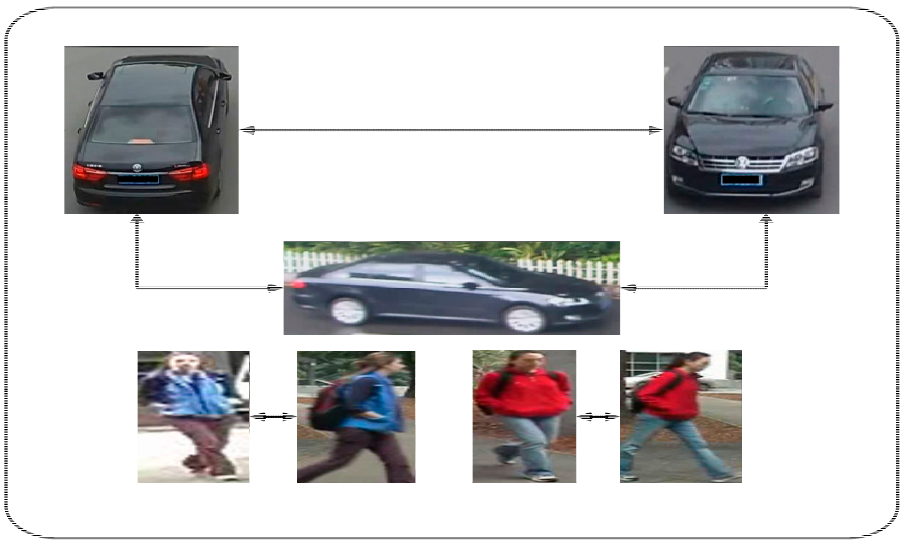
Figure 2. Different viewpoints of a vehicle and a person. Figure 2. Di ff erent viewpoints of a vehicle and a